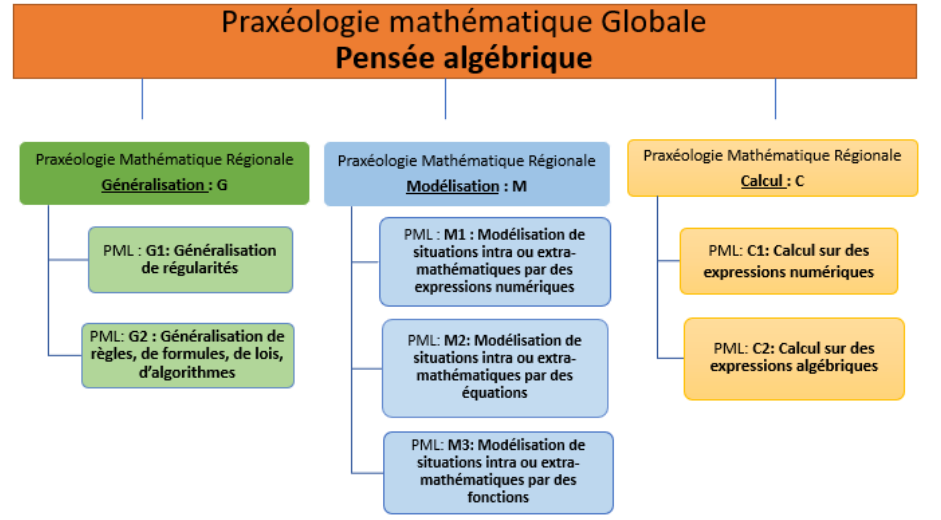
Fig. 1. Architecture du